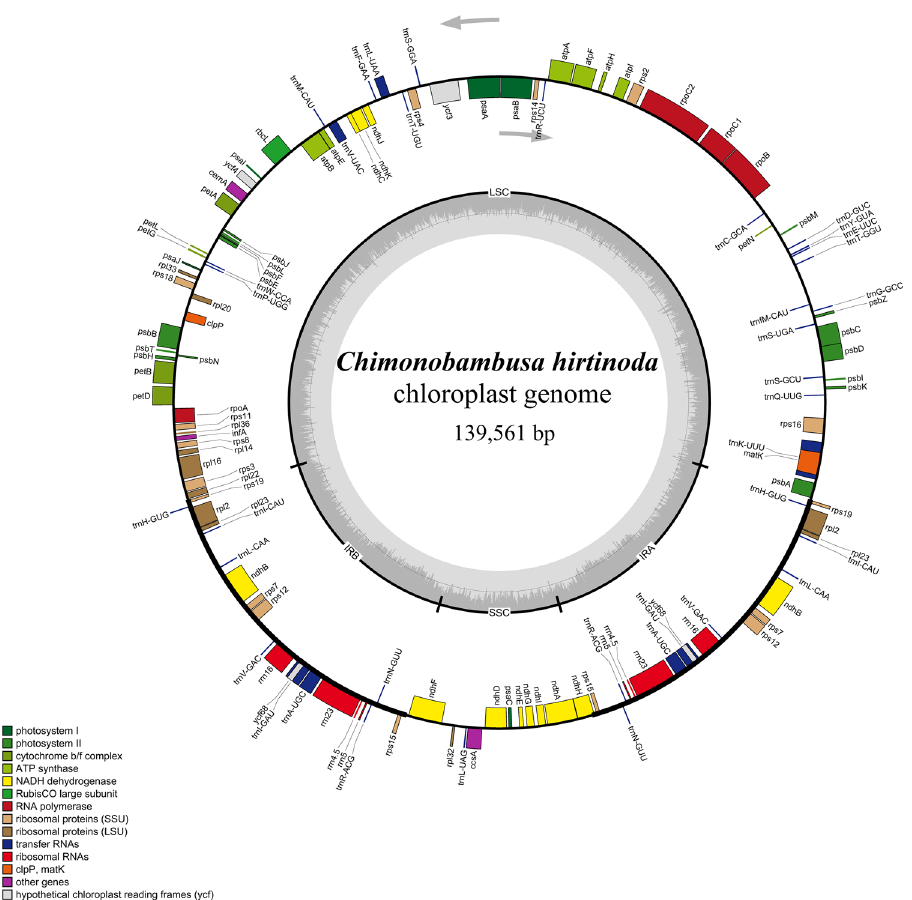
Figure 1. Chloroplast genome map of C. hirtinoda . Different colors represent different functional genes groups. Genes outside the circle indicate counterclockwise transcription, and genes inside the clockwise transcription. The thick black line on the outer circle represents the two IR regions. The GC content is the dark gray area within the